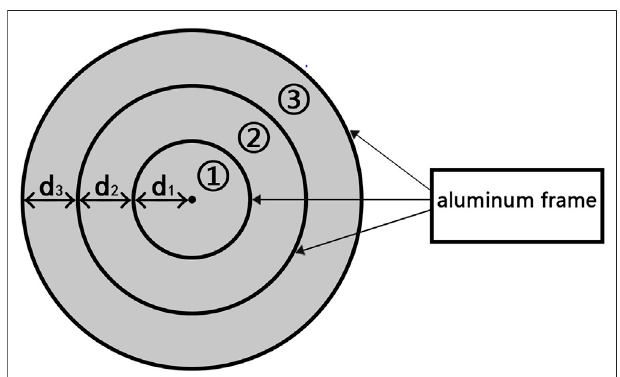
FIGURE 2 | Diagram of the model for a concentric circular single- layer composite magnetic control metasurface. Areas labeled ① , ② , and ③ , are fi lm positions; the thick black lines are fi xed frames made of aluminum.